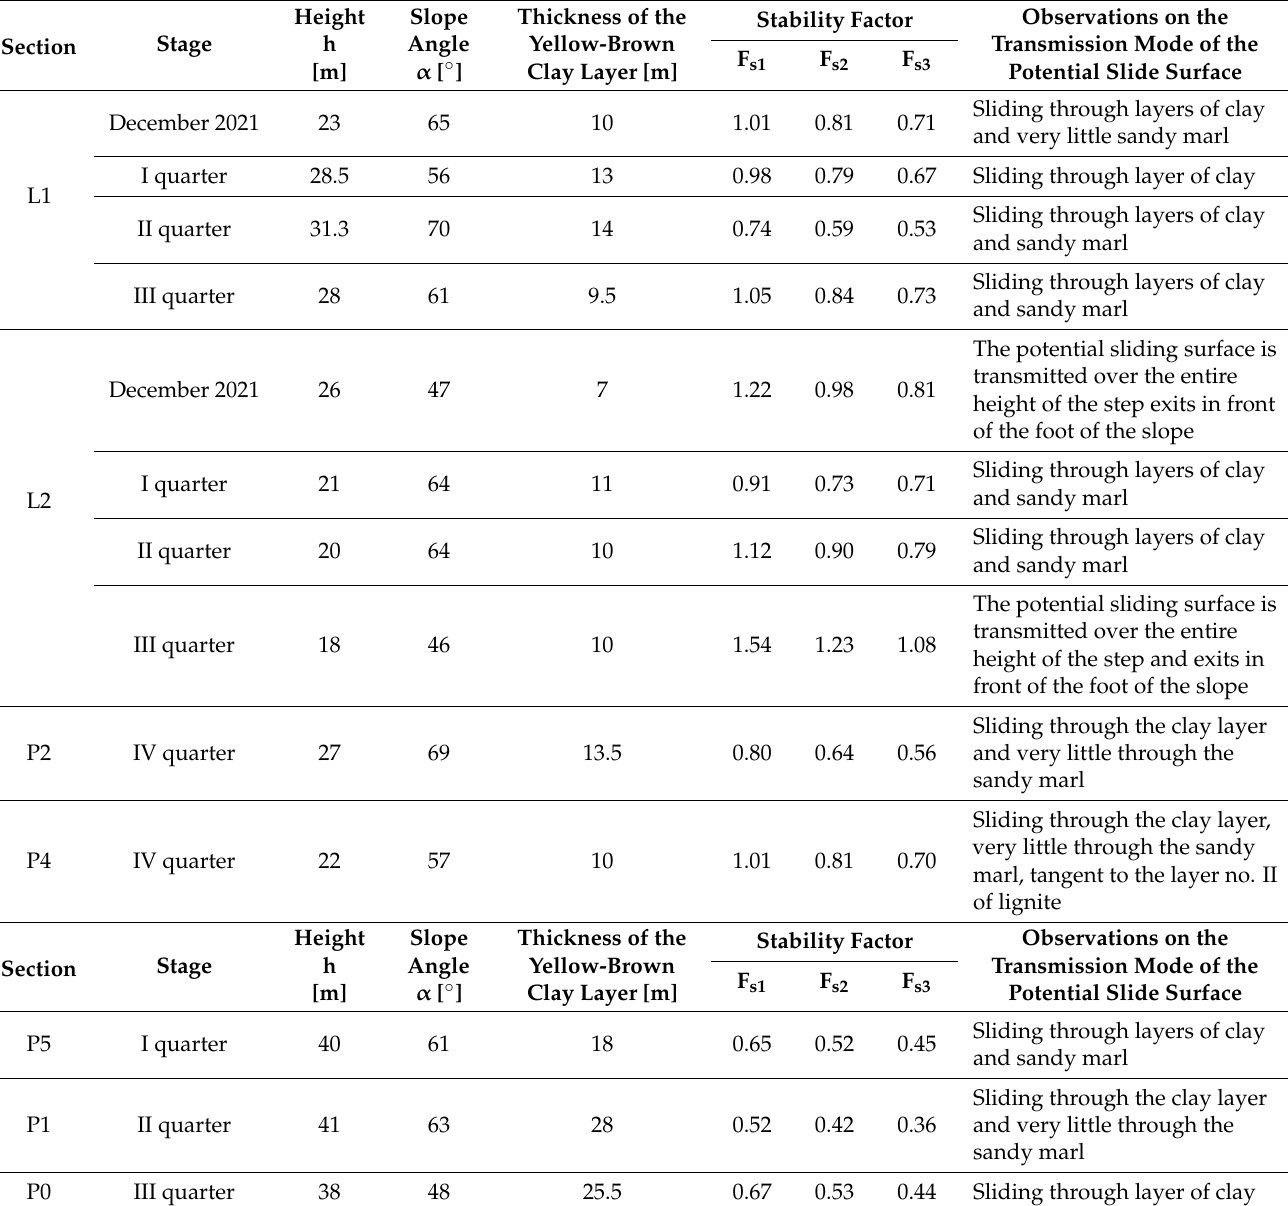
Table 2. Results of stability analyses for working fronts (sections L1, L2, P2, and